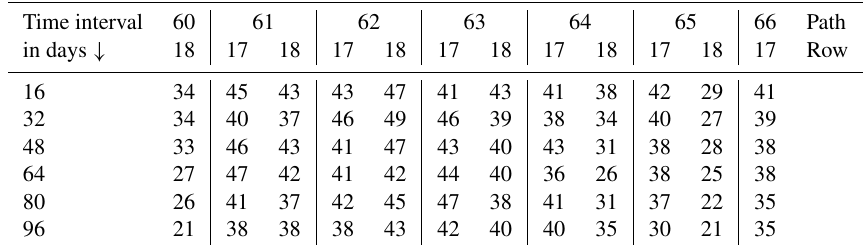
Table A1. Number of GoLIVE displacement products used in the generation of the product, ordered by location through path, row and by relative time